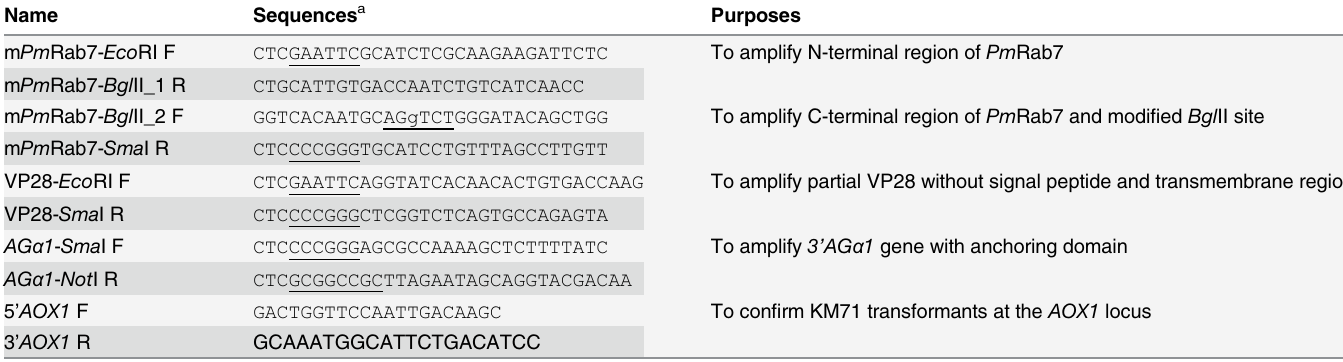
Table 1. Lists of DNA primers used in this